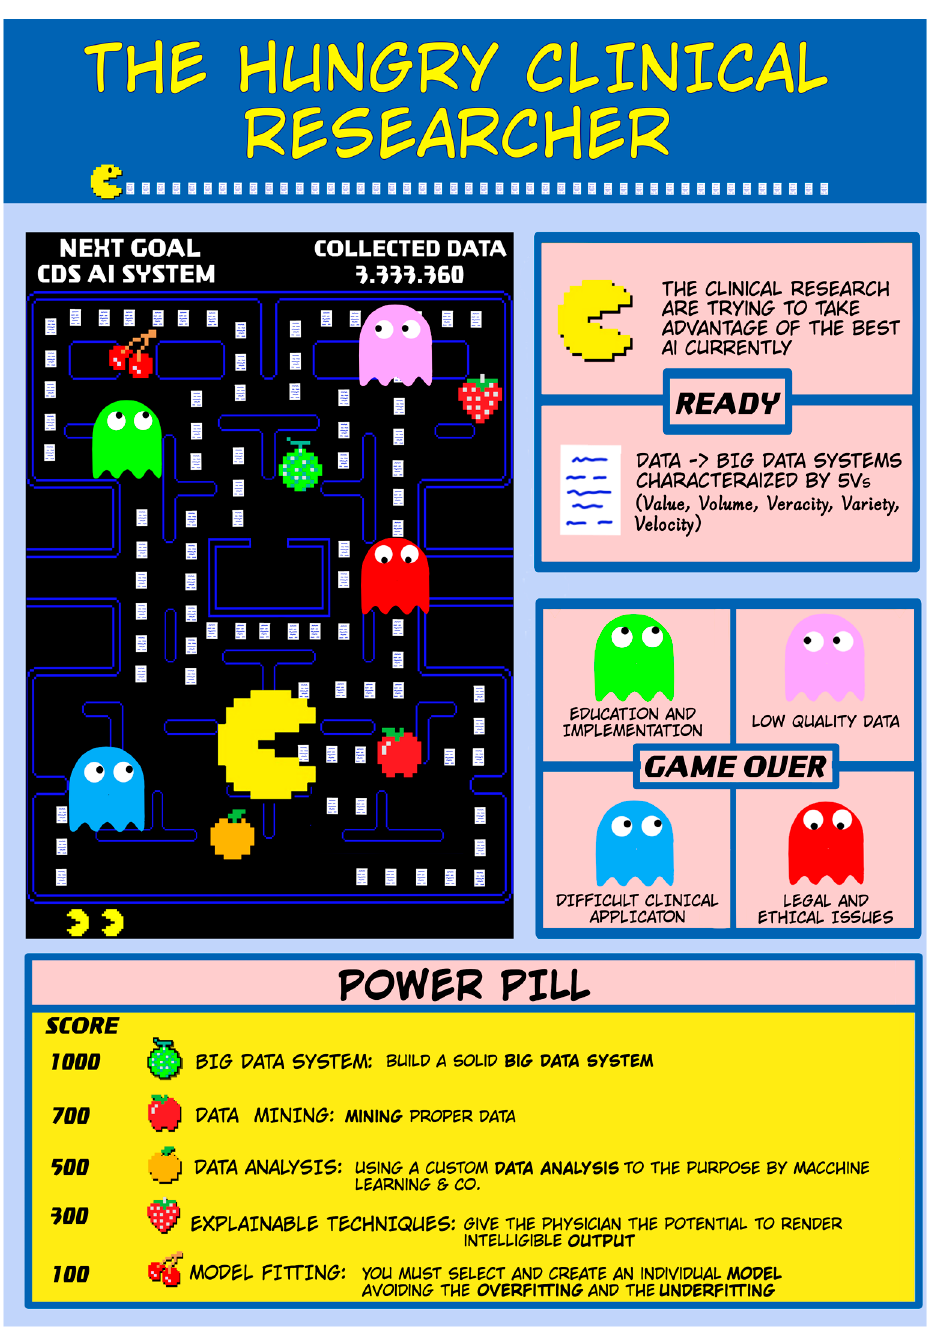
Figure 1. The Hungry Clinical Researcher. It is a metaphor for a clinical researcher’s job and shows the tools, objectives, and open issues of clinical research in AI.